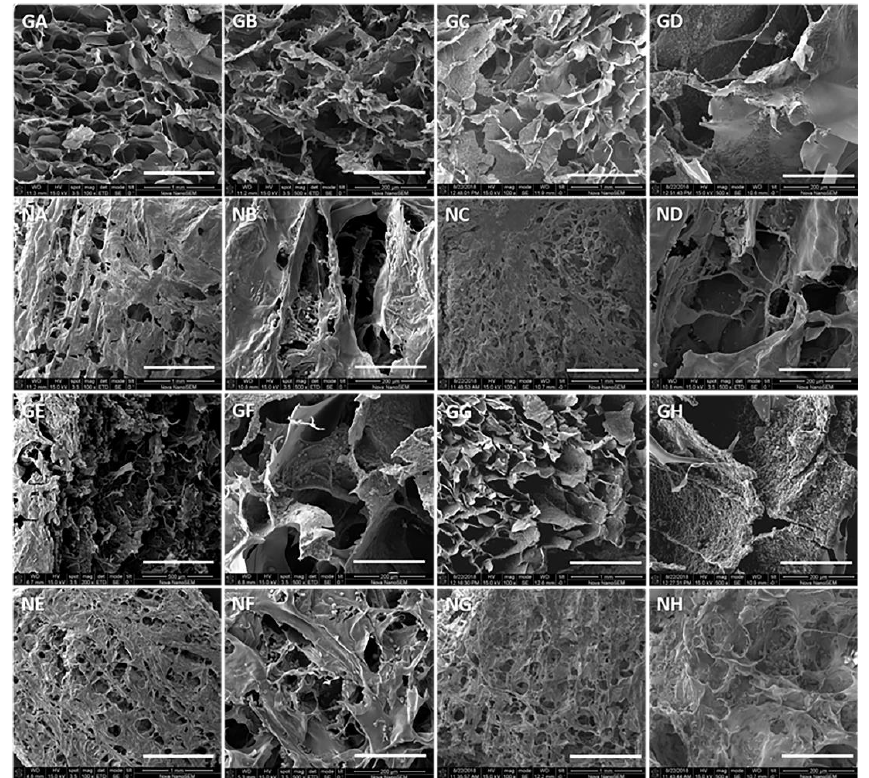
Figure 7. SEM of crosslinked scaffolds. The first letter in the code means crosslinked with (G)lutar- aldehyde or EDC/( N )HS. For the second letter in the code: ( A ) or ( B ) = 3 days; ( C ) or ( D ) = 7 days; ( E ) or F = 10 days; and ( G ) or ( H ) = 14 days. For the first and third columns, bar = 1.